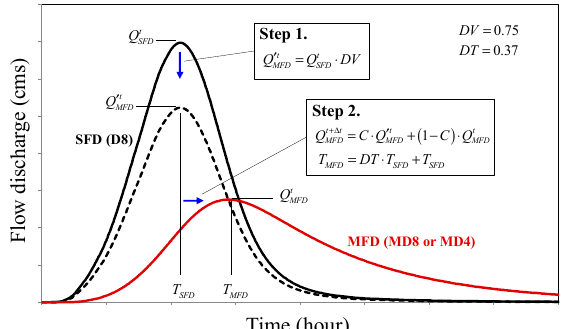
Figure 12. Flow discharge transformation analogizing to the hydrograph shape generated from an MFD runoff model.